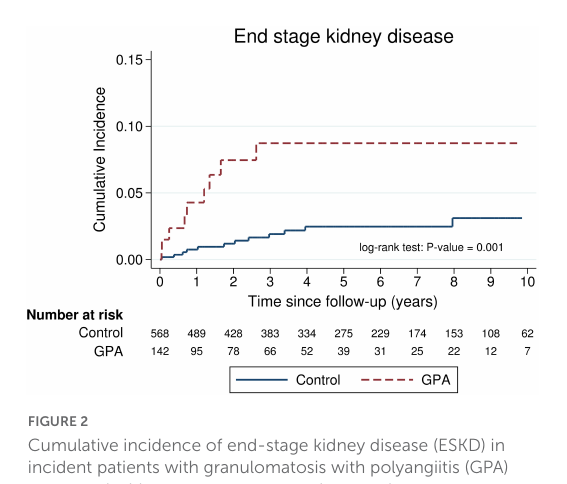
FIGURE2 Cumulative incidence of end-stage kidney disease (ESKD) in incident patients with granulomatosis with polyangiitis (GPA) compared with an age-, sex-, entry time- and comorbidity-matched